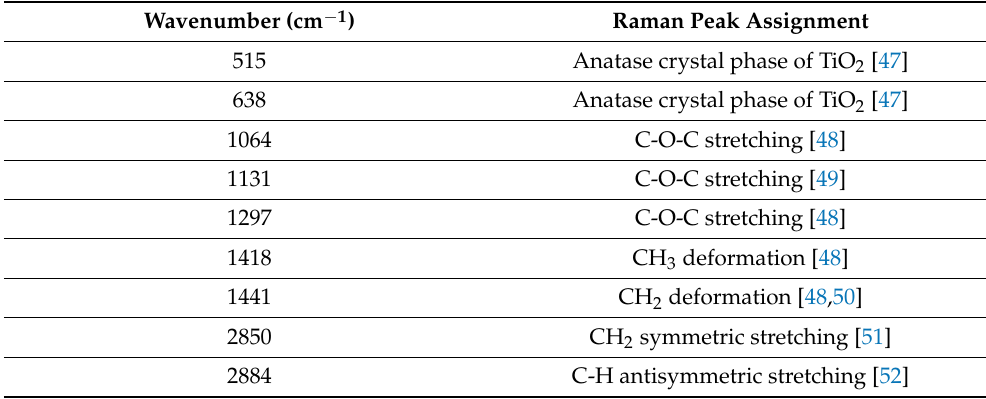
Table 1. Major Raman peaks identified and their related